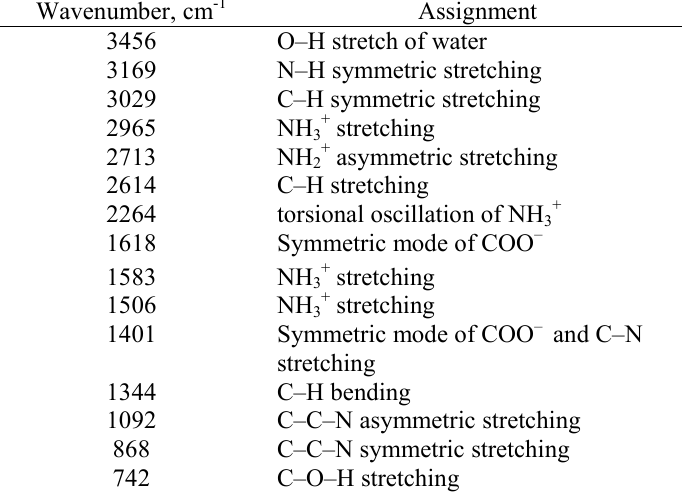
Figure 3. FTIR spectrum of CLMHCl crystal. Table 2. FTIR spectral assignments for CLMHCl single